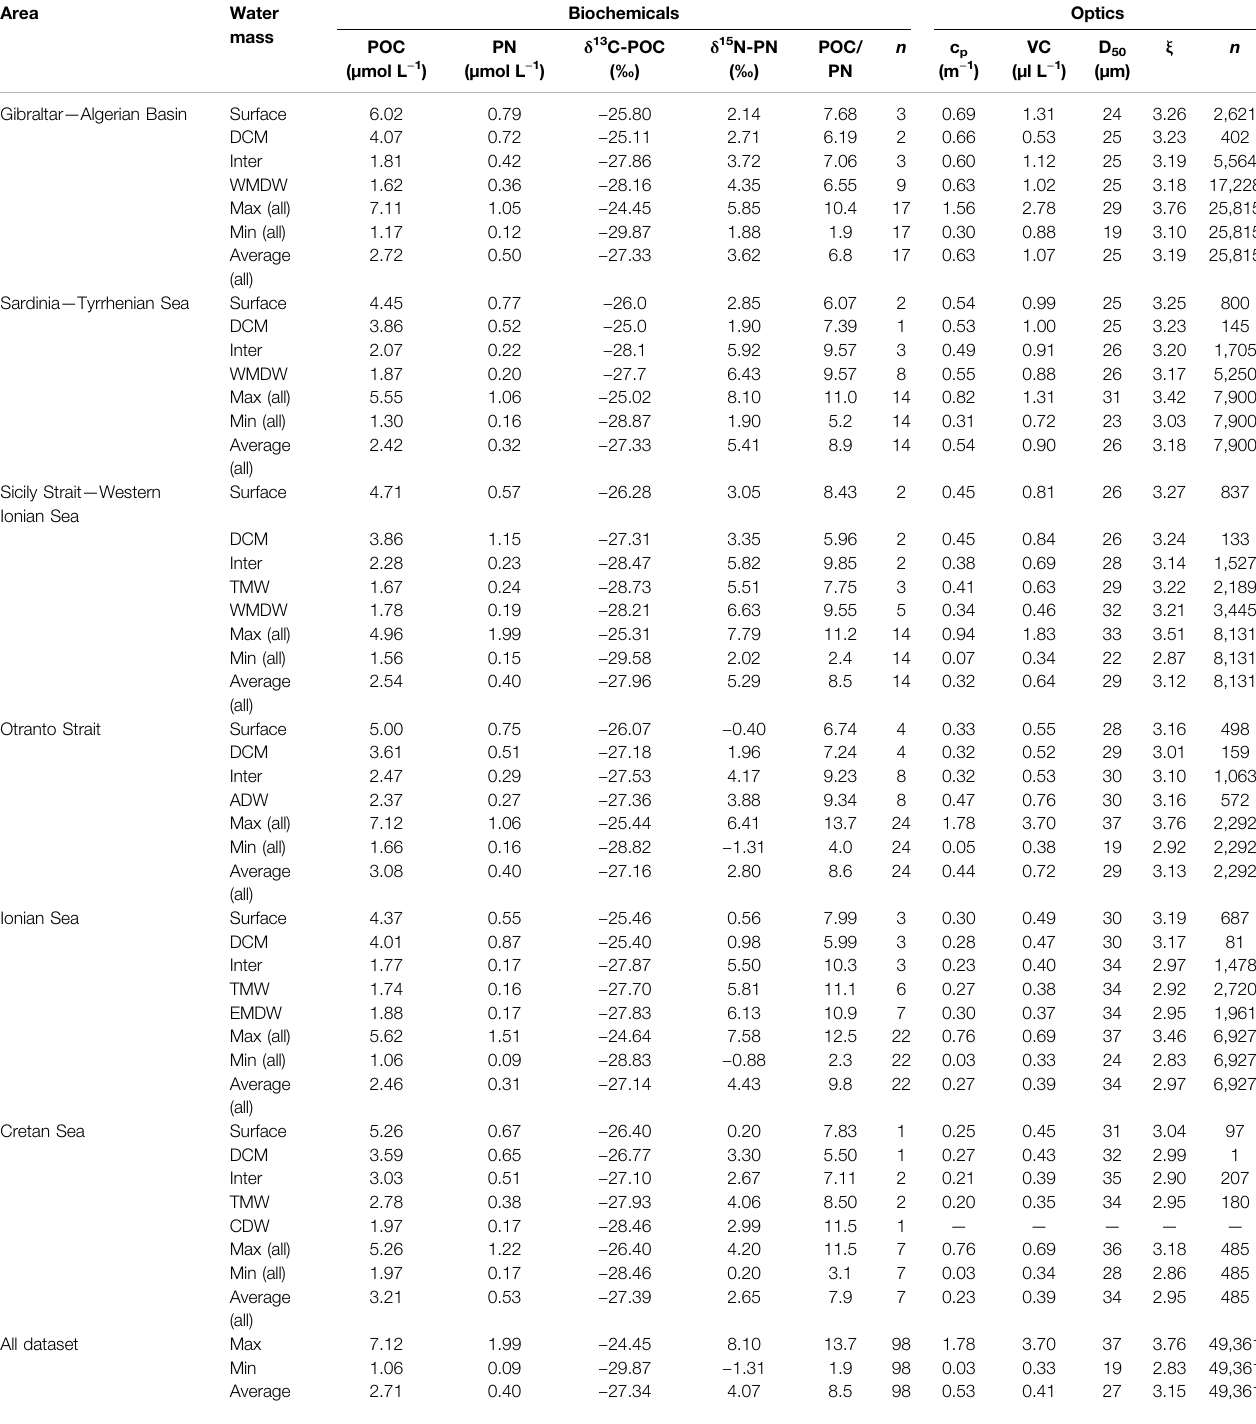
TABLE 1 | Ranges and mean values of the determined optical and biochemical parameters considered in this study in the entire Mediterranean Sea as well as in the various considered sub-regions, i.e., Gibraltar/Algerian Basin (stations 94 – 137), Sardinia/Tyrrhenian Sea (stations 75 – 93), Sicily Strait/western Ionian Sea (stations 50 – 72), OtrantoStrait(stations39 – 42),IonianSea(stations7 – 50excludingtheOtrantoStrait)andtheCretanSea(station2).Withineachoftheconsideredsub-regionsmeanvalues of all parameters are also reported for the identi fi ed main water masses. The abbreviations of the identi fi ed main water masses are de fi ned in the text. “ Inter ” signi fi es intermediate water masses regardless of their origin (LIW, CIW, etc.). Area